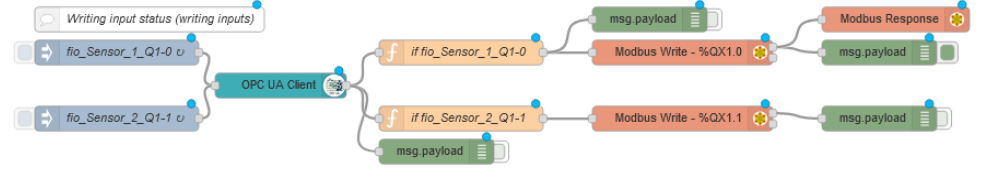
Figure 29. Communication from Factory I/O to